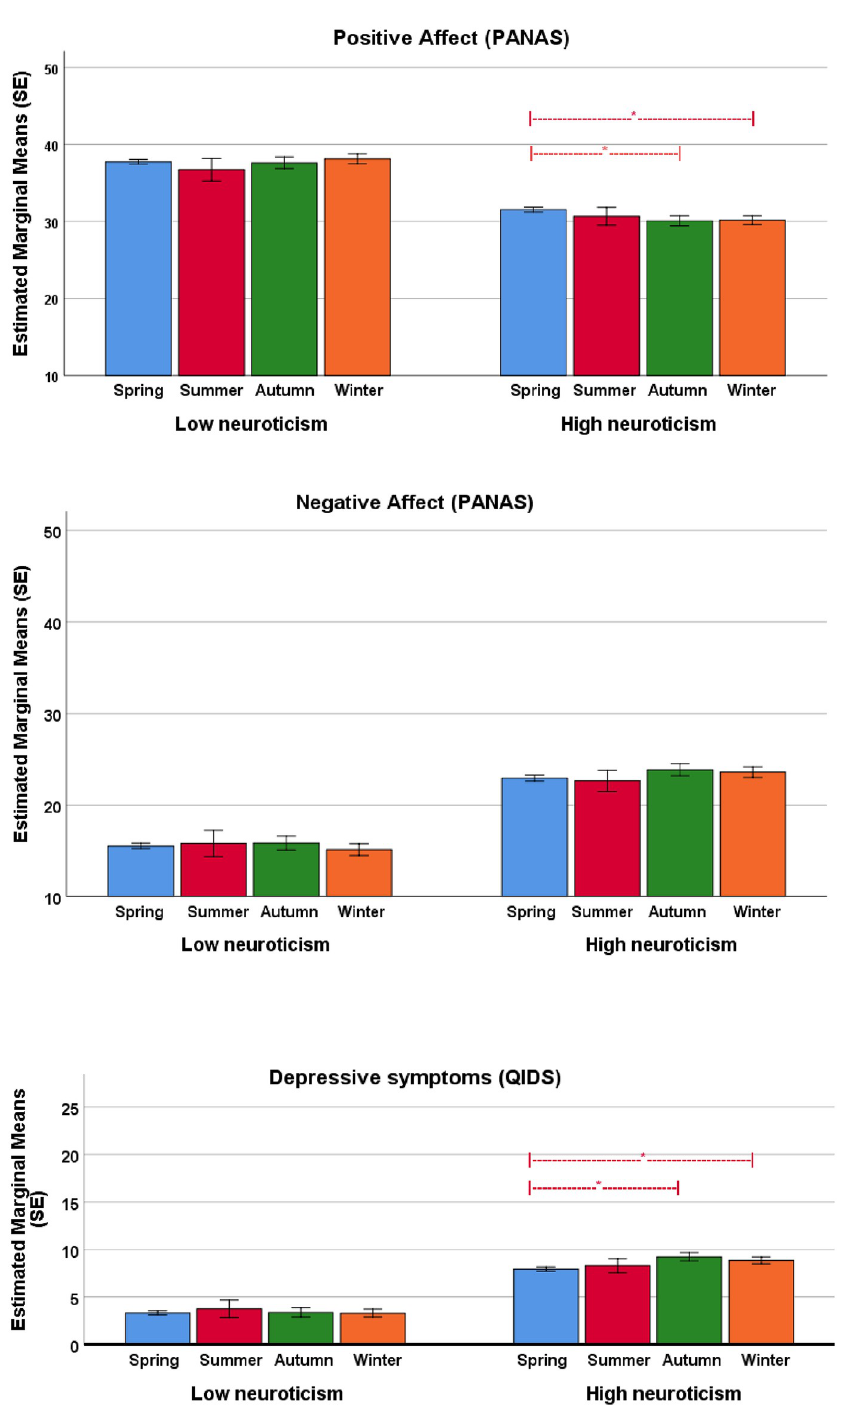
Fig 2. Positive and negative affect (PANAS) and depressive symptoms (QIDS) by season for high and low neurotic respondents. Estimated means and standard errors (SE) based on 1,000 bootstrap samples from ANCOVA models adjusted for age, gender, partner status, education, employment status, and income.